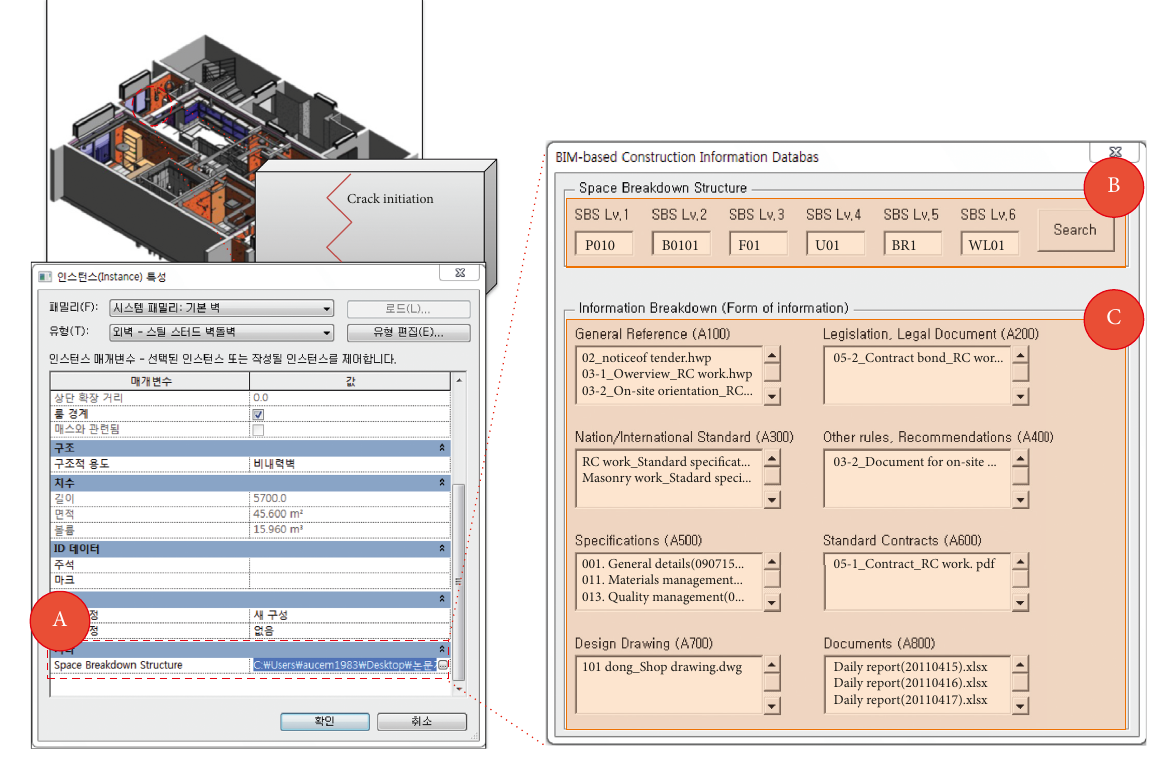
Figure 12: Database search screen for the collection of claim-related